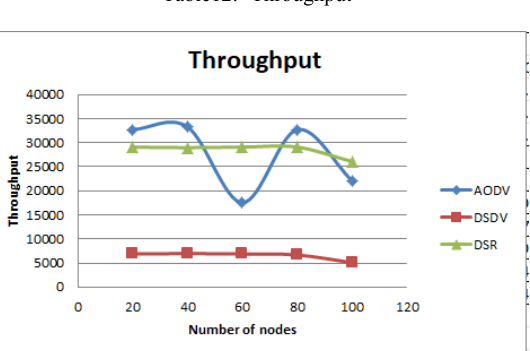
Table12:- Throughput